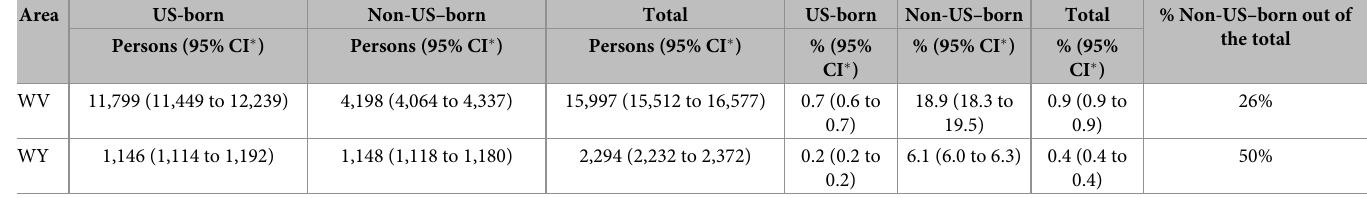
26 states, the estimated LTBI prevalence in the non-US–born population was � 15% (Fig 1 and Table 3). The state-level LTBI prevalence by age groups and race/ethnicity are presented in S1 and S2 Figs in S1 File. Each state’s predicted total number of people with LTBI, as well as grouped by medical risk factor, age group, and race/ethnicity, is presented in S1 Table. Median estimated state-level total population LTBI prevalence was 2.4% (interquartile